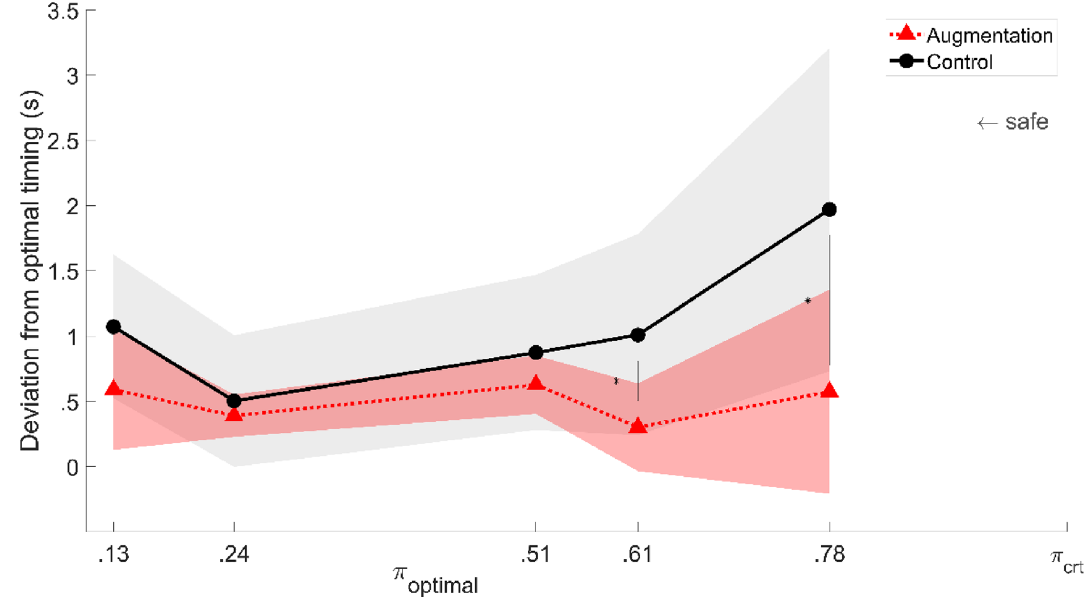
Figure 7. Inter-individual average timing error between the moment of the deck-landing attempt and the optimal moment during safe deck-landing windows as a function of π optimal in Control and Augmentation conditions (plain black and dotted red curves, respectively). Data on LL and HL groups were pooled together. The colored areas give the standard deviations of individual means.